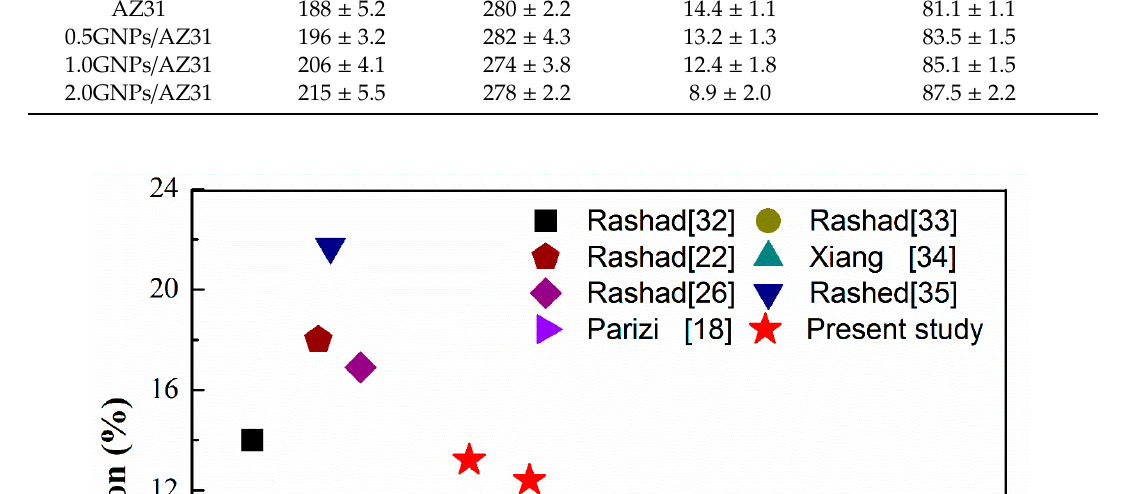
Table 4. Mechanical properties of AZ31 alloy and the GNPs/AZ31 composites.